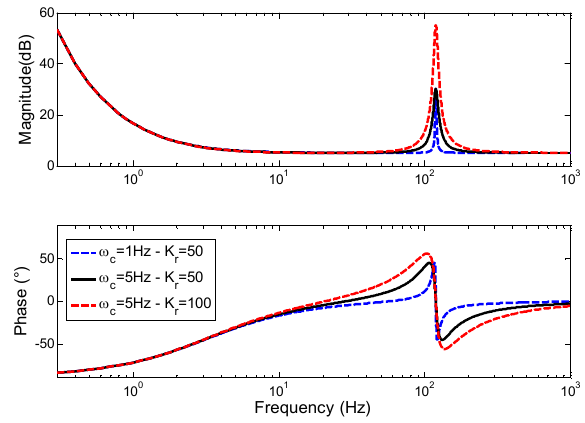
Figure 12. Bode diagram of the PI + RC. Proportional ‐ integral: PI; resonant controllers: RC.